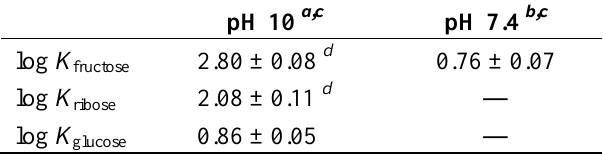
Table 1. Apparent affinity constants for 1:1 complexes between SQ-BA dye and